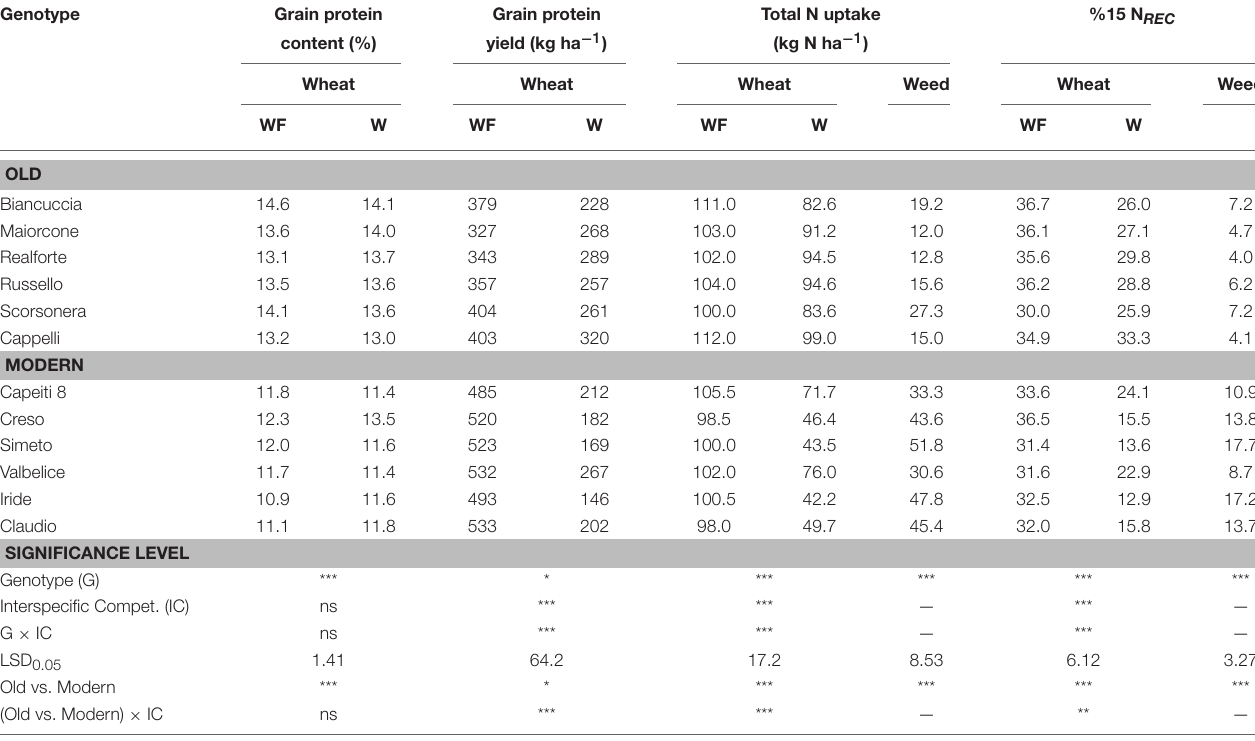
For total N uptake and % 15 N REC weed data are also reported. Data are the means of two growing seasons. * , ** , *** significant at the 0.05, 0.01, and 0.001 probability level, respectively. ns, not